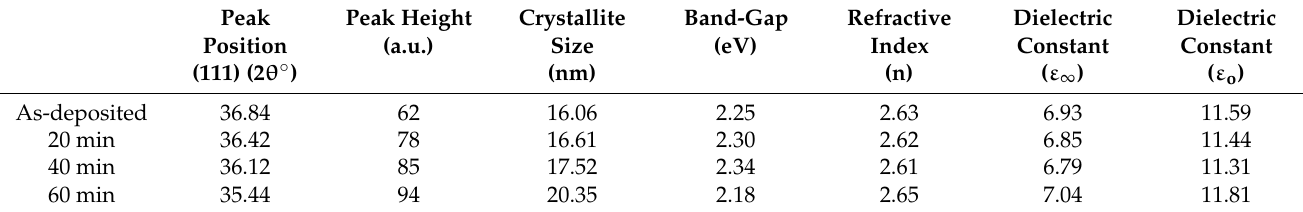
Table 1. Estimated structural and optical properties of the Cu x O thin films with respect to the annealing time.